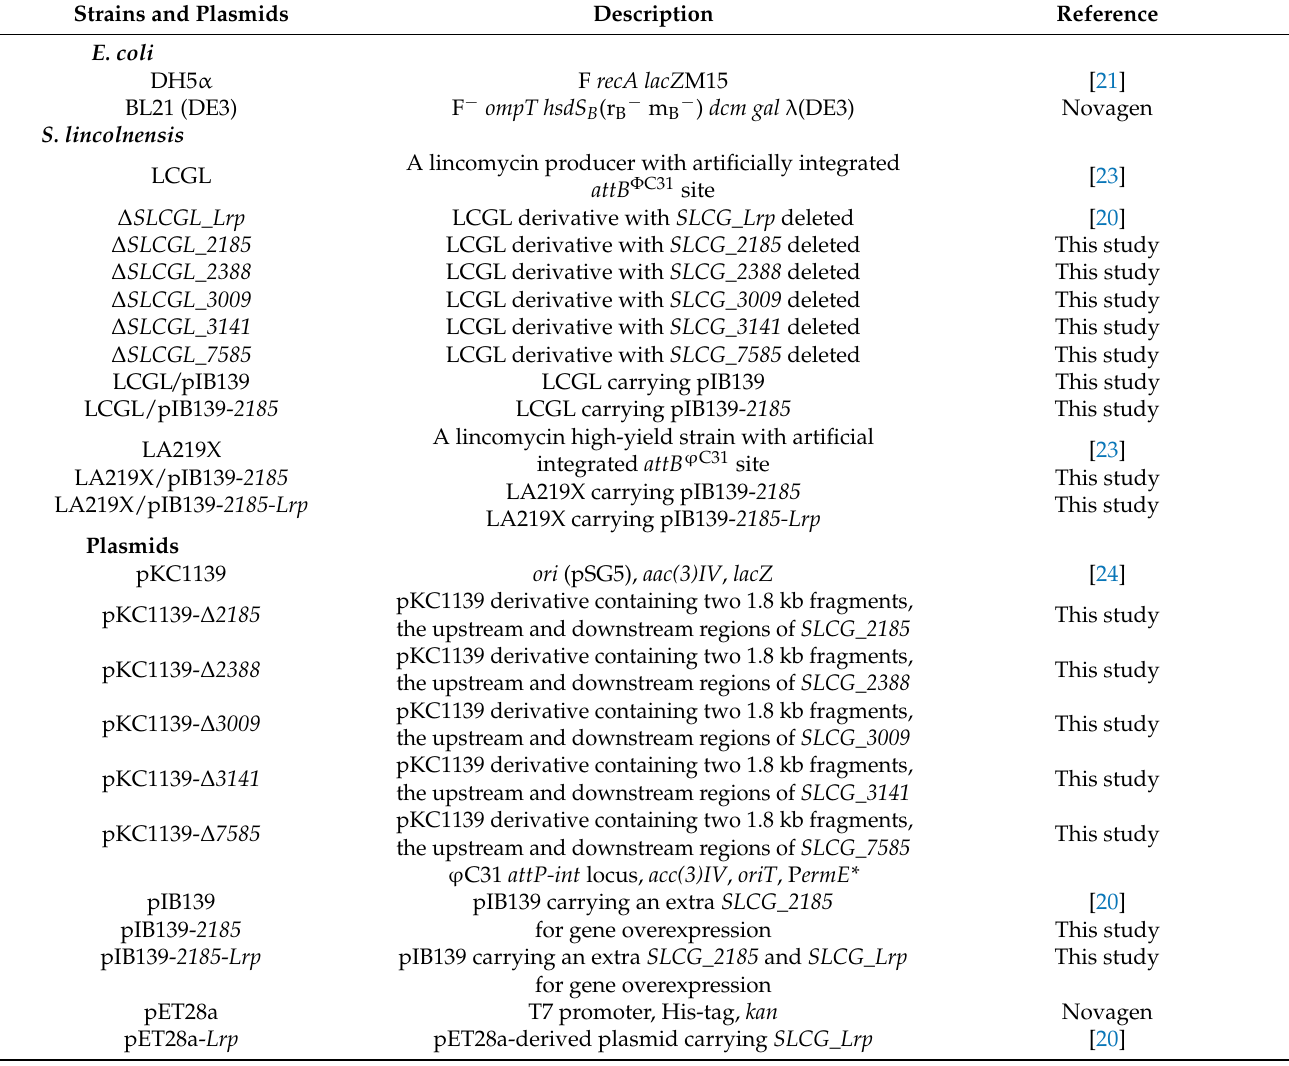
Table 1. Bacterial strains and plasmids used in this